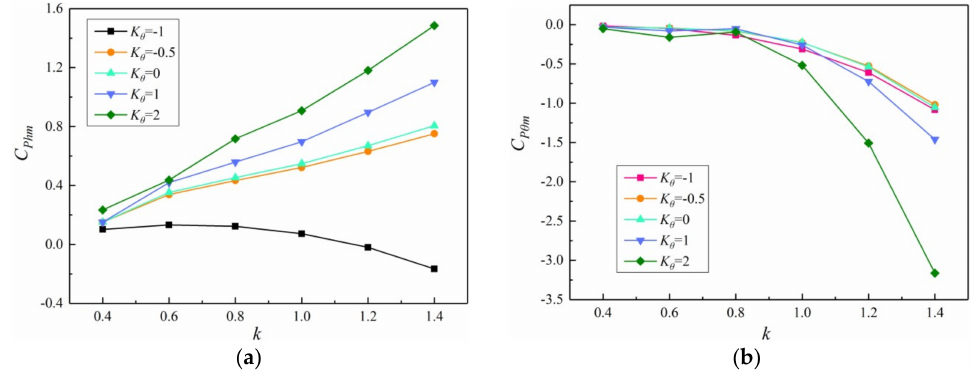
Figure 10. The C Phm and C P θ m of parallel foils at different K θ : ( a ) C Phm curves under different k ; ( b ) C P θ m curves under different k